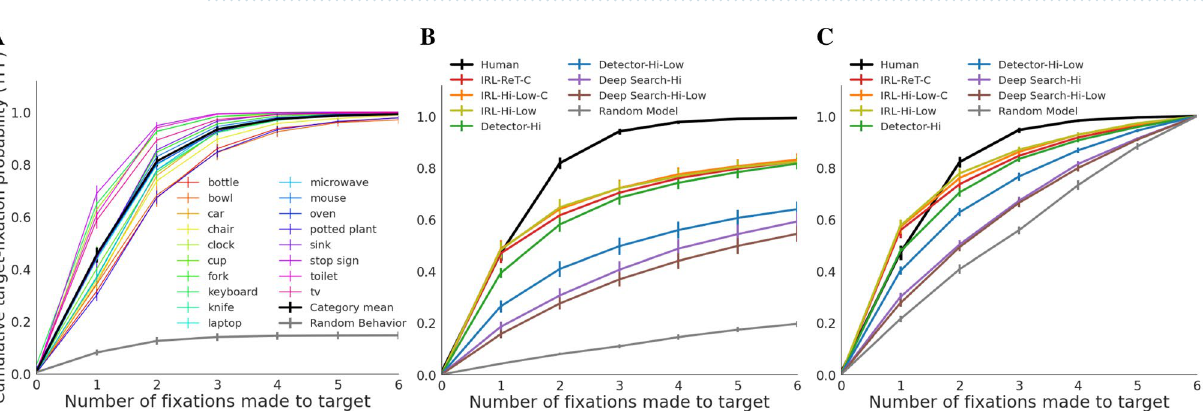
Figure 3. Basic behavioral analyses of the target-present data from COCO-Search18, grouped by the 18 target categories. Blue plots (left two) show the manual measures of reaction time (RT) and response accuracy (ACC). Olive plots (top row) show gaze-based analyses of categorical guidance efficiency: number of fixations made before the button press (NumFix), time until first target fixation (T2T), and number of fixations made until first target fixation (NumFix2T). Orange plots (bottom row) show gaze-based measures of target verification: time from first target fixation until response (TTFix2R), total time spent fixating the target (TonT), and the number of re-fixations on the target (ReVisitT). Values are means over 10 participants, and error bars represent standard errors.